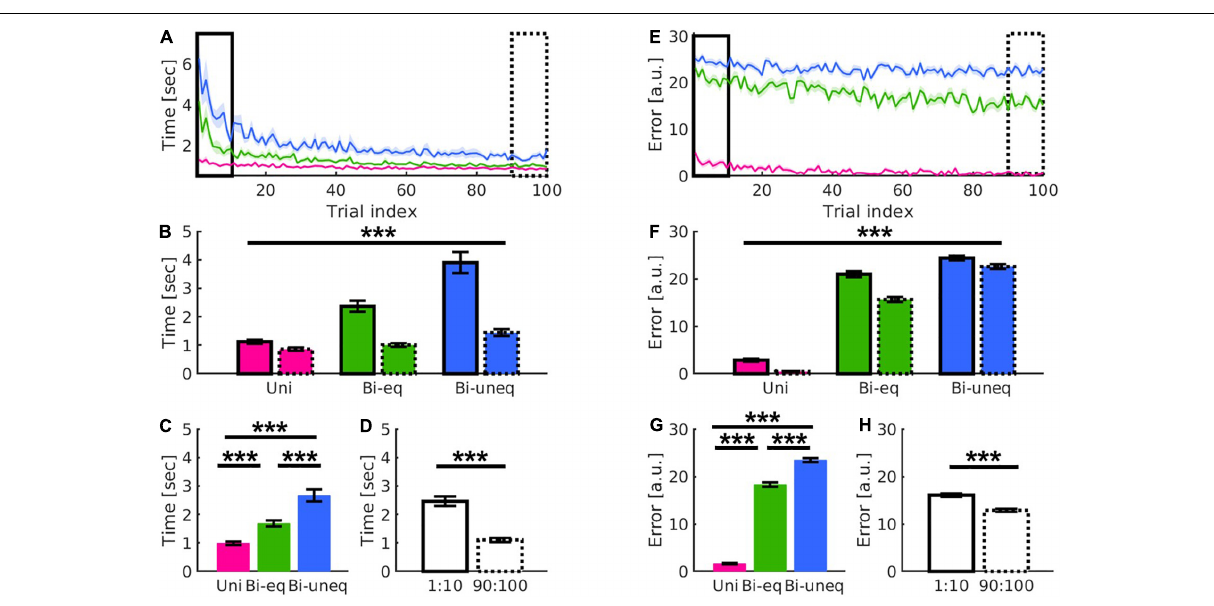
FIGURE 4 | Results showed distinct patterns for the different levels of bimanual interaction ( Uni : pink; Bi eq : green; Bi uneq : blue) in movement time (A–D) and error (E–H) . (A,E) Qualitative presentation of the interaction of condition and time. (B,F) Quantitative presentation of the interaction of condition and time by comparing first ten (solid frame) and last ten (dashed frame) trials. This suggests that movement time and error decreased differently for the three conditions over time. (C,G) Quantitative presentation of the main effect of condition. (D,H) Quantitative presentation of the main effect of time. Error bars are standard errors of the mean. Significance stars ∗∗∗ mean p <